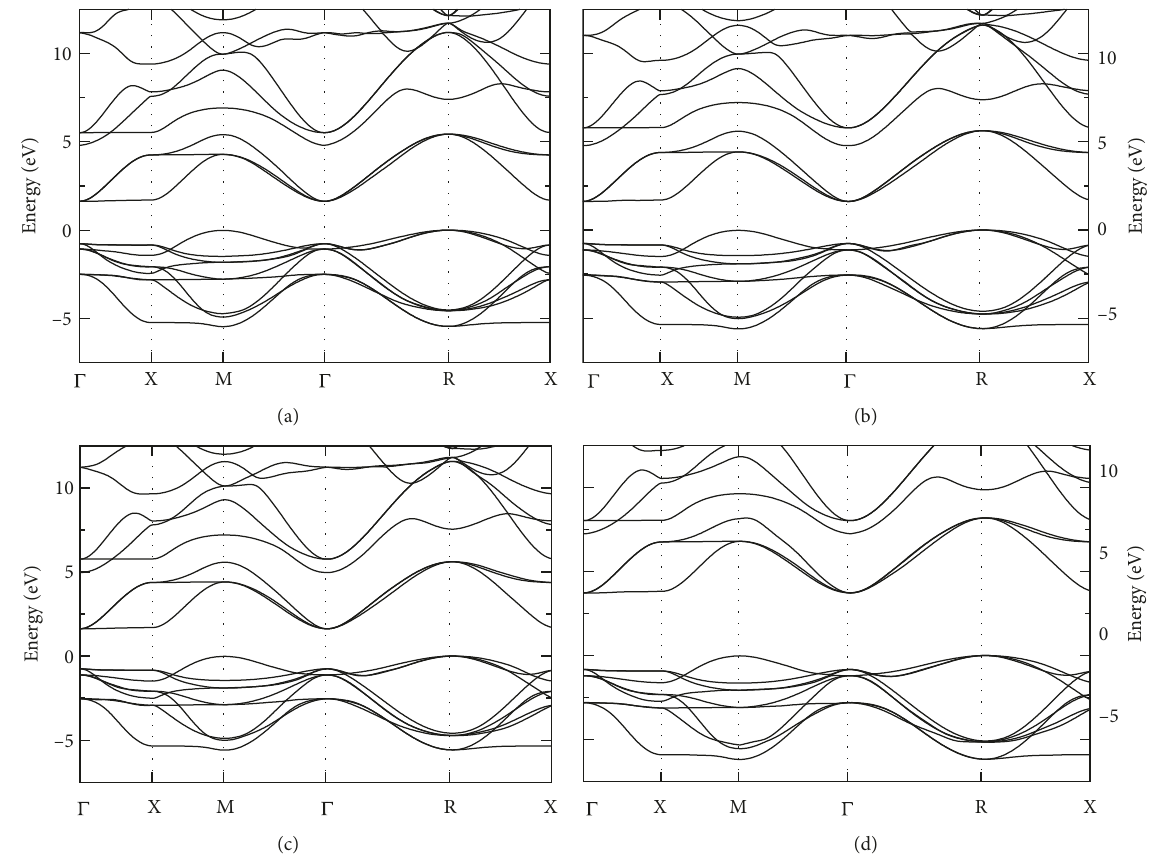
Figure 3: NaNbO 3 electronic band structures calculated for the simple cubic perovskite correlation potentials: (a) the conventional PBE functional of Perdew et al. [16], (b) the PBEsol functional revised for solids [18], (c) the AM05 functional [17], and (d) the PBE0 hybrid functional [19]. Zero energy has been rescaled to the valence band maximum (at the M